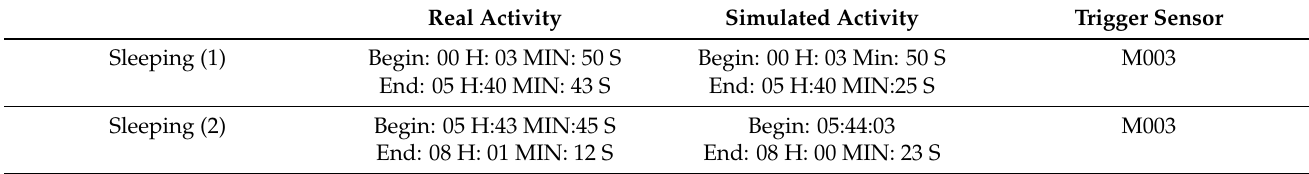
Table 2. Timestamp comparison between real and simulated activities on 4 November